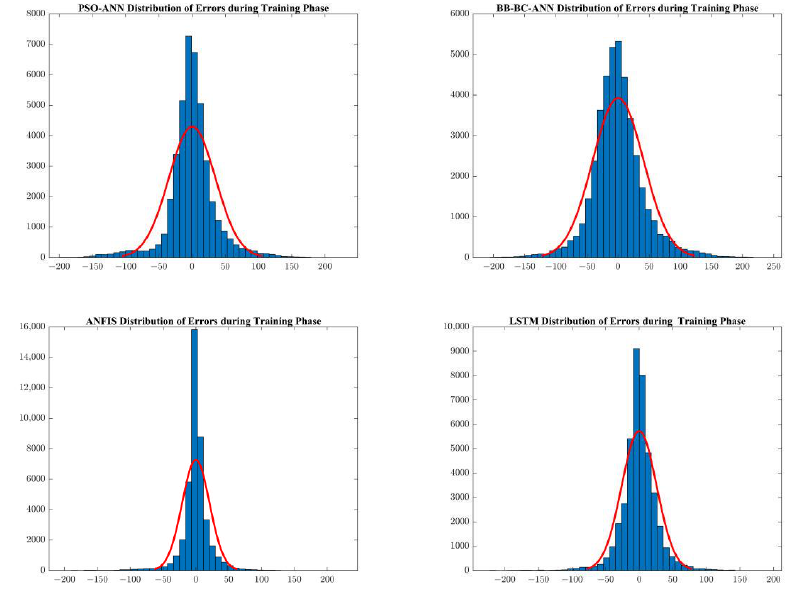
Figure 10. Error distribution for the training phase.